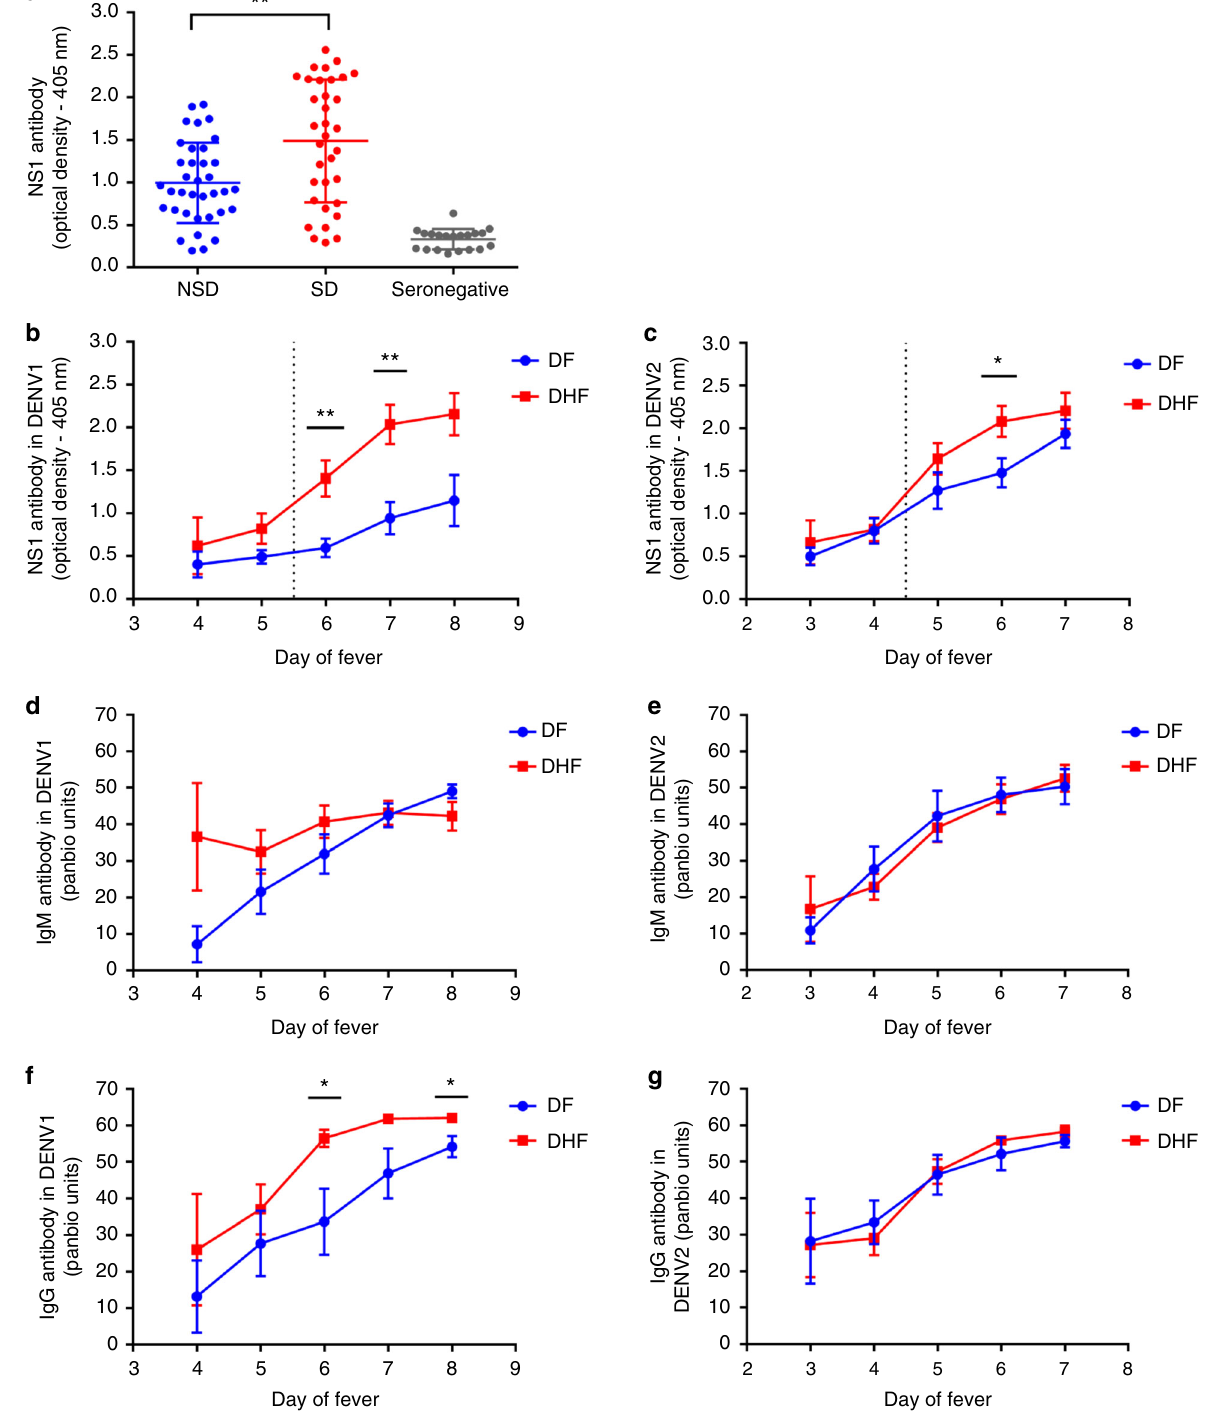
Fig. 1 Kinetics of DENV NS1-speci fi c antibody responses in acute dengue. a NS1 antibody levels in patients with past severe dengue (SD) ( n = 34), non- severe dengue (NSD) ( n = 36) and dengue seronegatives ( n = 20). b DENV1 NS1-speci fi c IgG antibody levels, measured in patients with an acute secondary DENV1 infection causing DF ( n = 10) or DHF ( n = 10) using ELISA. c DENV2 NS1-speci fi c IgG antibody levels were measured in patients with an acute secondary DENV2 infection causing DF ( n = 12) or DHF ( n = 23) using ELISA. DENV-speci fi c IgM antibody (Panbio unit) in patients with an acute secondary DENV1 ( d ) and DENV2 ( e ). DENV-speci fi c IgG antibody levels were measured in patients with an acute DENV1 ( f ) and DENV2 ( g ) infection. Differences between serial values of NS1-speci fi c antibodies and IgM and IgG in patients with DHF and DF were compared using the Holm – Sidak method. The vertical dotted line represents the day in which the patients entered the critical phase. NS1 antibody levels in patients with DHF are indicated in red, and in those with DF in blue. Error bars indicate mean and standard error of mean (SEM). * P < 0.05, ** P <